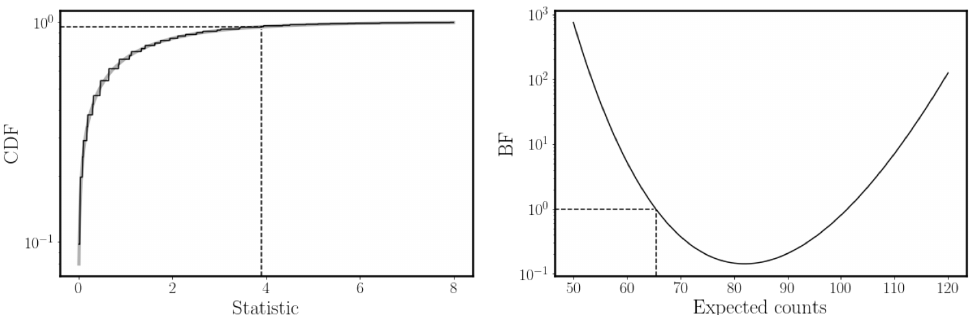
Figure 4. A comparison between the frequentist ( left panel ) and Bayesian ( right panel ) conclusion from the experiment result N on = 82 on the hypothesis that the gamma ray expected counts is 65.4 and no background is present. Left panel: in black the cumulative distribution function (CDF) of the statistic defined in Equation (15) from 10 6 simulations assuming s = 65.4, while in grey the expected CDF of a χ 2 random variable. The step shape of the CDF of the statistic is due to the discrete nature of the Poisson distribution. Dashed lines show the point in which the statistic is 3.9 and the CDF is 0.952. Right panel: evolution of the BF defined in Equation (19) as a function of the expected counts s 2 , using s 1 = 65.4 and N on = 82. Dashed lines show the point in which the expected counts are 65.4 and by definition the BF is